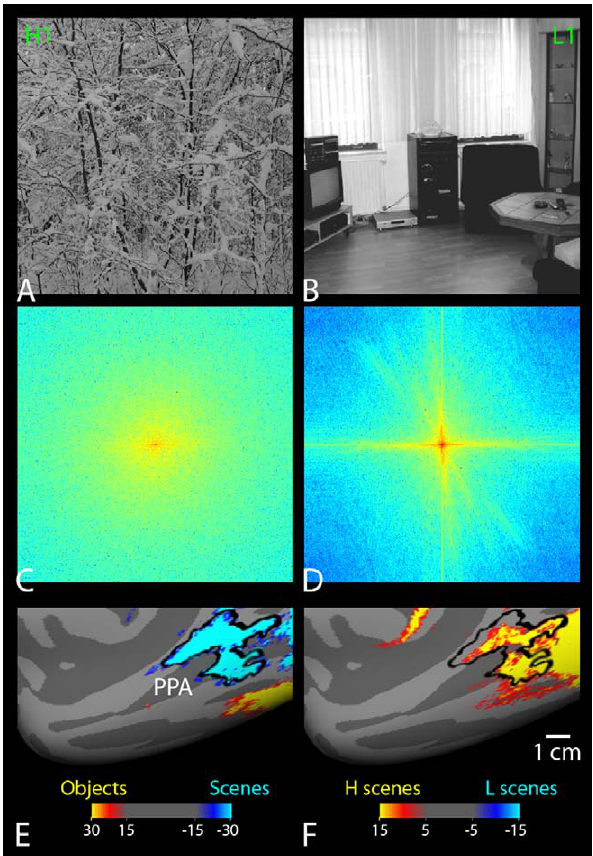
Figure 7. PPA activity reflects the spectral variation in natural scenes. (A and B) Examples of scenes with relatively higher (H scenes) (A) and lower (L scenes) (B) power at high SFs. These two images had the highest (H1) and the lowest (L1) normalized high SF power in our scene image database (see Figure S10 for details). (C and D) The FFT of the H1 (C) and L1 (D) images. The H1 scene had more high SF power (and less low SF power) than the L1 scene. The frequency bias was not confined to specific scene categories (e.g., outdoor versus indoor scenes). (E) PPA was localized based on a blocked-design comparison between scene stimuli and single-object stimuli, in five human subjects. The group-averaged activity map is displayed on a medial view of an averaged inflated cortical surface (right hemisphere). (F) The compar- ison between H scenes and L scenes revealed a strong fMRI activity for H scenes within PPA. This activity extended posteriorly, in occipito- temporal cortex.